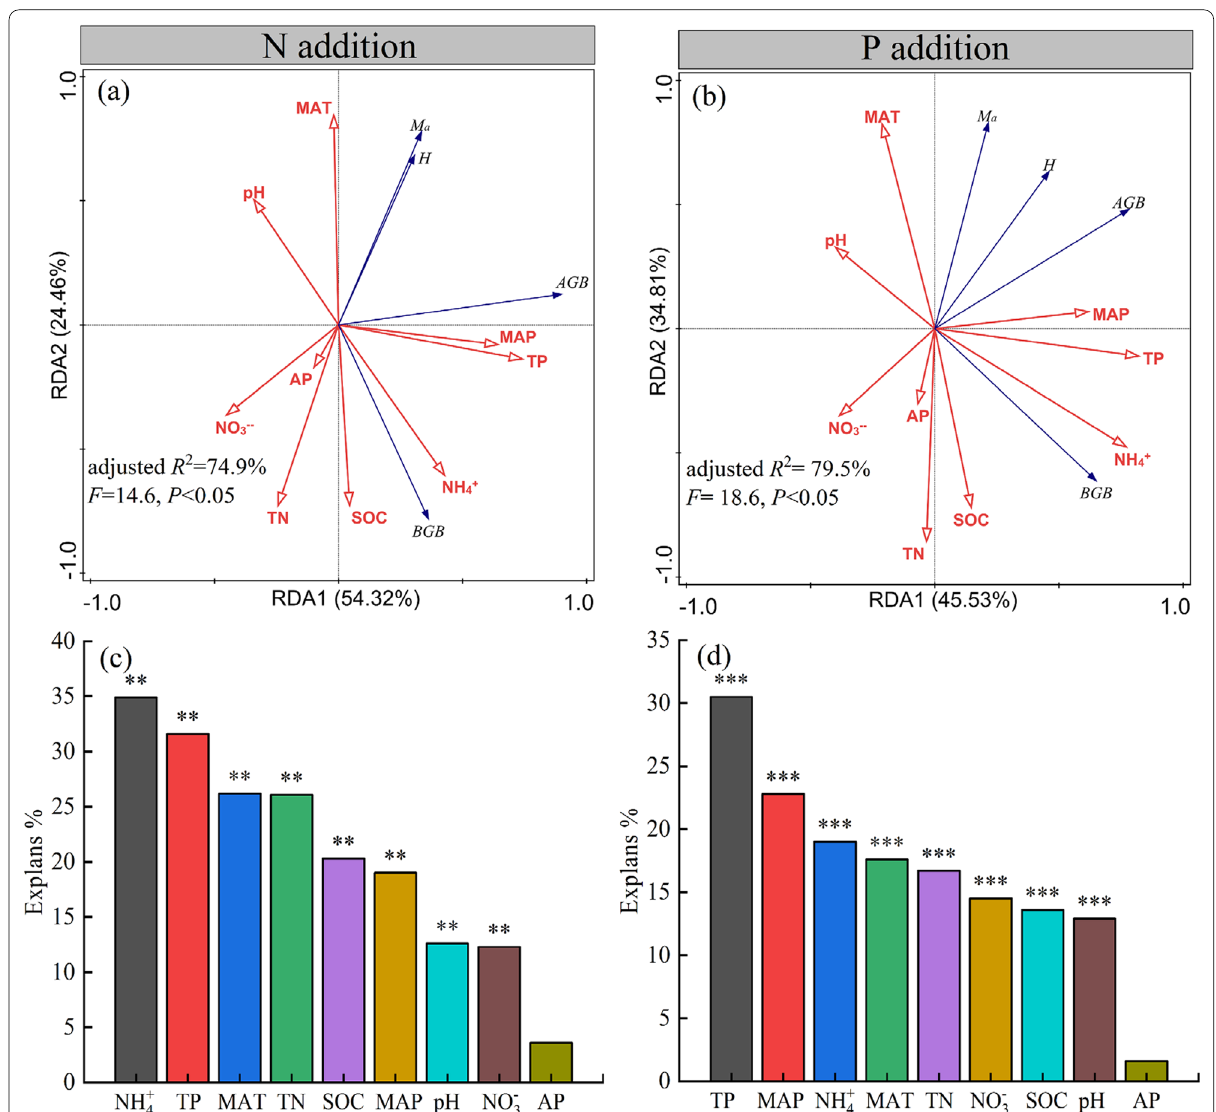
Fig. 6 Redundancy analysis (RDA) of community biomass and diversity (blue lines) in relation to environmental factors (red lines) under N or P addition. In Fig. 5a, RDA axes 1 and 2 explained 54.32% and 24.46% of the variation, respectively (adjusted R 2 RDA axes 1 and 2 explained 45.53% and 34.81% of the variation, respectively (adjusted R 2